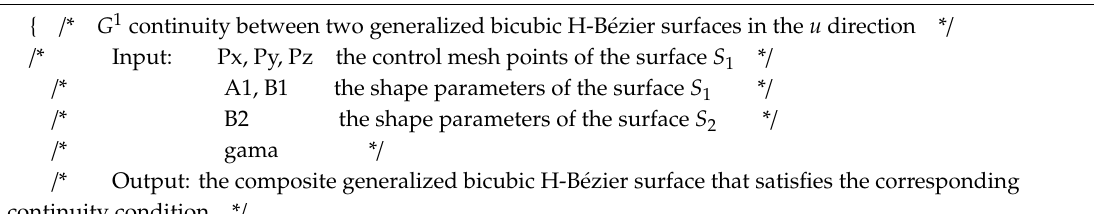
Algorithm 2. SurfaceJoint(Px, Py, Pz, A1, B1, B2,